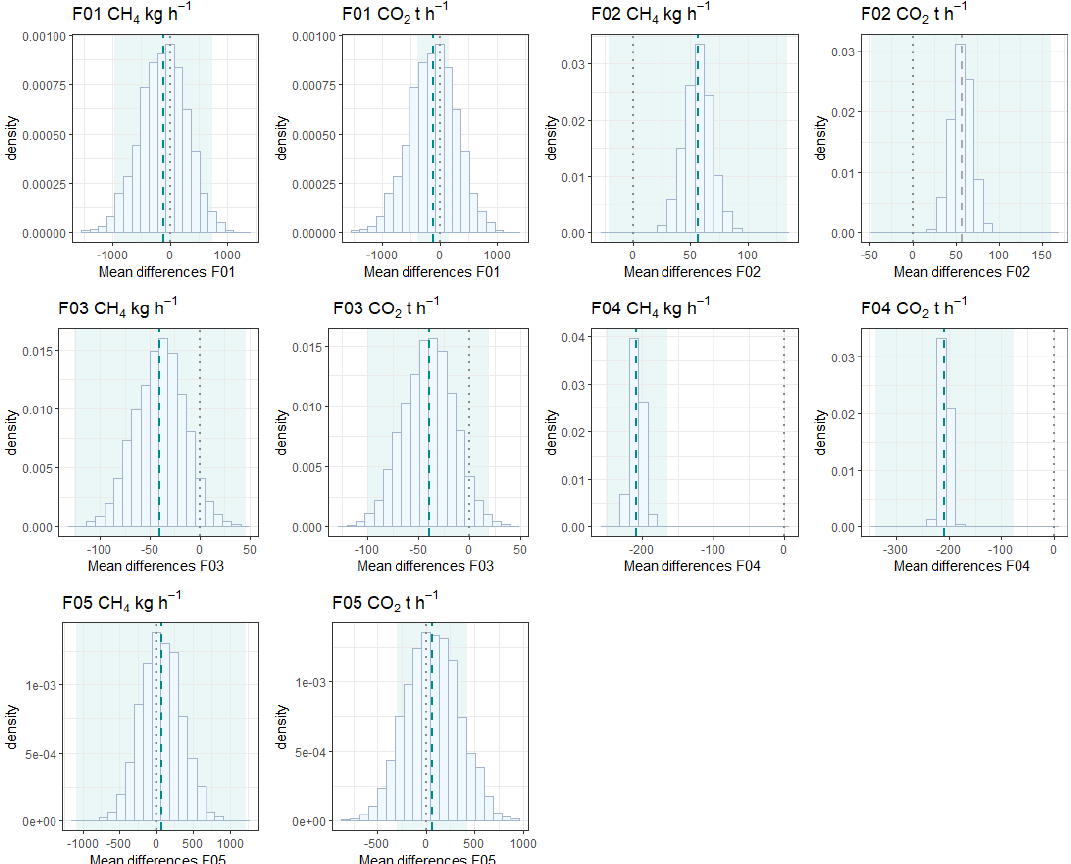
Figure 8. Distributions of the mean difference between all fits of CH 4 and CO 2 for the SciAv and TERRA algorithms are shown as a light blue histogram. The mean difference between the standard estimates is plotted as a teal dashed lined, and the range in the difference between standard estimates is shown as a light teal box. A grey dot dashed line is drawn at zero as a reference point for the location of exact agreement between the